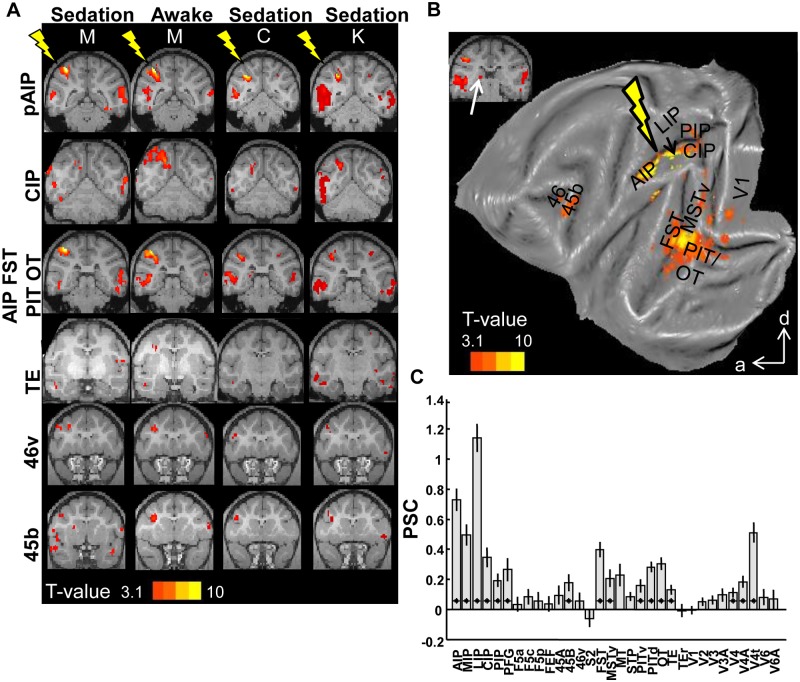
Microstimulation of area pAIP.A. T-score maps for the contrast EM-NoEM for individual animals, represented on coronal sections (template anatomy). Leftmost columns show data for monkey M in the sedated and the awake state, respectively; rightmost columns show results for monkey C and K. See files pAIP* in [25]. B. T-score maps for the contrast EM-NoEM, group data, represented on a flat map. a: anterior; d: dorsal. C. Percent signal change. * p < 0.05; corrected for multiple comparisons (32 ROIs). Black lines indicate standard error of the mean.